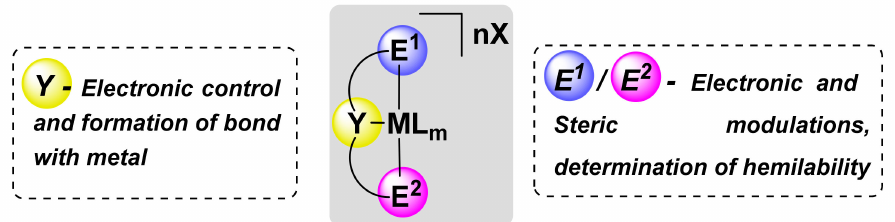
Figure 1. General formula of pincer-type complexes, where E 1 and E 2 are a neutral two-electron donor group, Y is usually represented by an anionic carbon atom of a 2,6-disubstituted aryl moiety, X and L are counterions and auxiliary ligands, and M is metal, m and n – number of auxiliary ligands and counterions